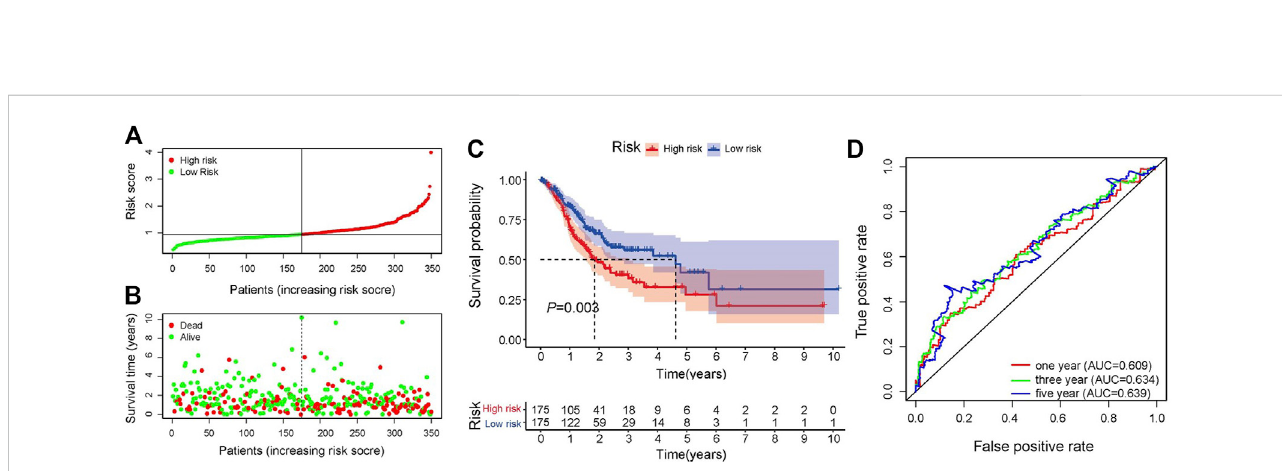
FIGURE 3 Validation of the signature. (A) Distribution of risk scores, patients are grouped by the median of risk scores. (B) Distribution of survival in high- and low- risk groups (C) Kaplan-Meier analysis of high- and low-risk groups. (D) 1-, 3-, and 5-year OS predictive ROC plots and AUC values.